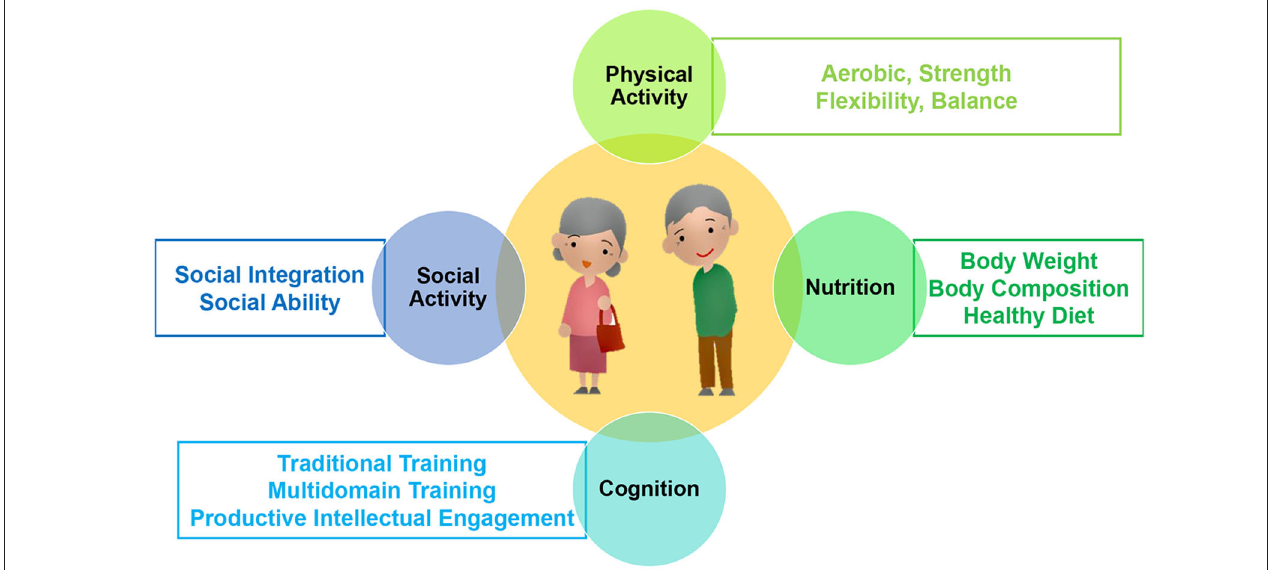
FIGURE 1 | The NESTORE coaching domains and